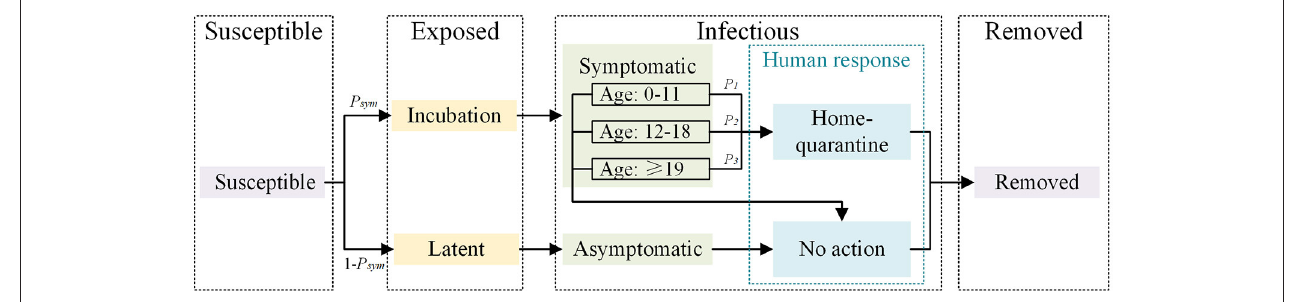
FIGURE 3 | The SEIR model integrating human